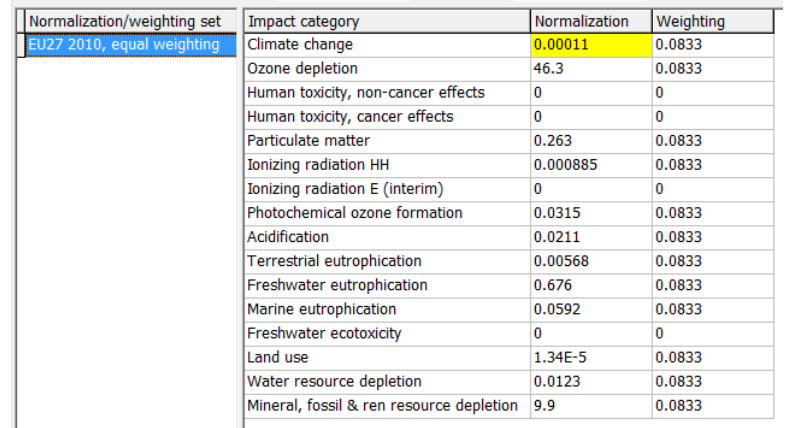
Figure 1. International Reference Life Cycle Data System (ILCD) normalization and weighting factors used.